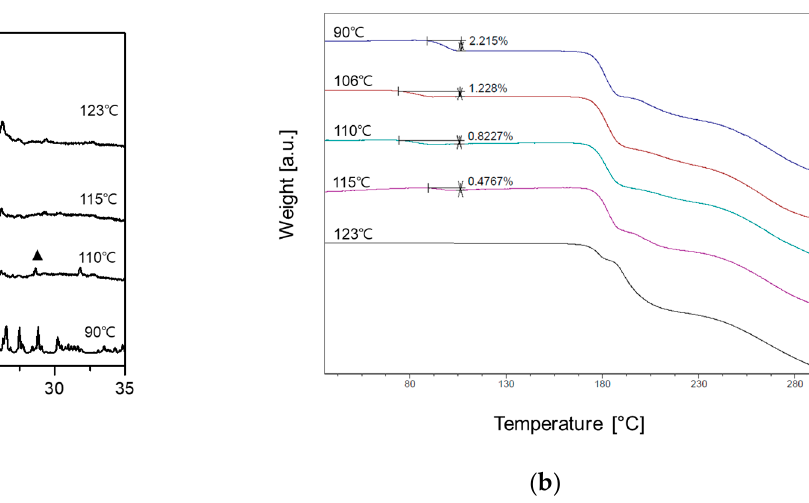
Figure 9. Phase transformation analysis of DBE monohydrate crystals obtained during HSM thermal scanning at 90 °C, 110 °C, 115 °C, 123 °C: ( a ) Powder X-ray diffraction (PXRD) pattern, ( b ) Thermogravimetric Analysis (TGA) data (heating rate 10 °C/min, tem- perature range: 30 °C–300 °C).